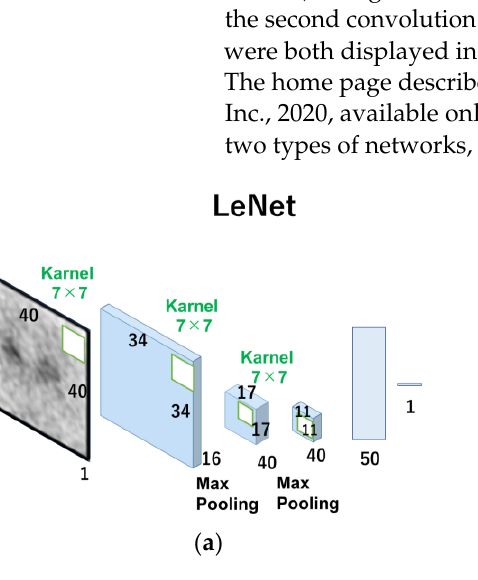
Figure 1. Scheme of the algorithms of ReNet and Alexnet used in this study. The number under the square boxes is the number of filters. LeNet ( a ), the basic shapes of CNN, consists of alternating layers of convolutional and pooling layers, and AlexNet ( b ) consists of five convolutional layers and three fully connected